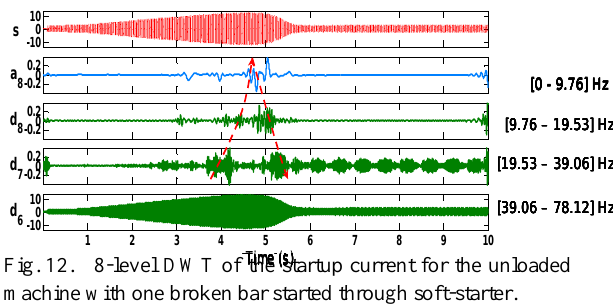
Fig. 12. 8-level DWT of the startup current for the unloaded machine with one broken bar started through soft-starter.